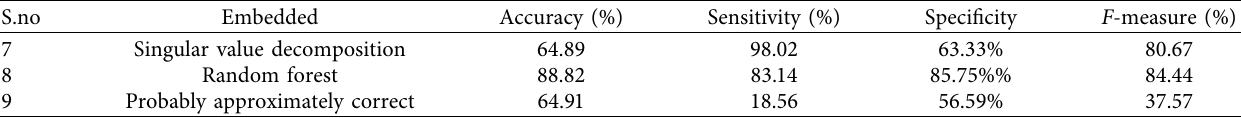
Table 9: Top 3 Embedded approaches performance for gene microarray dataset.